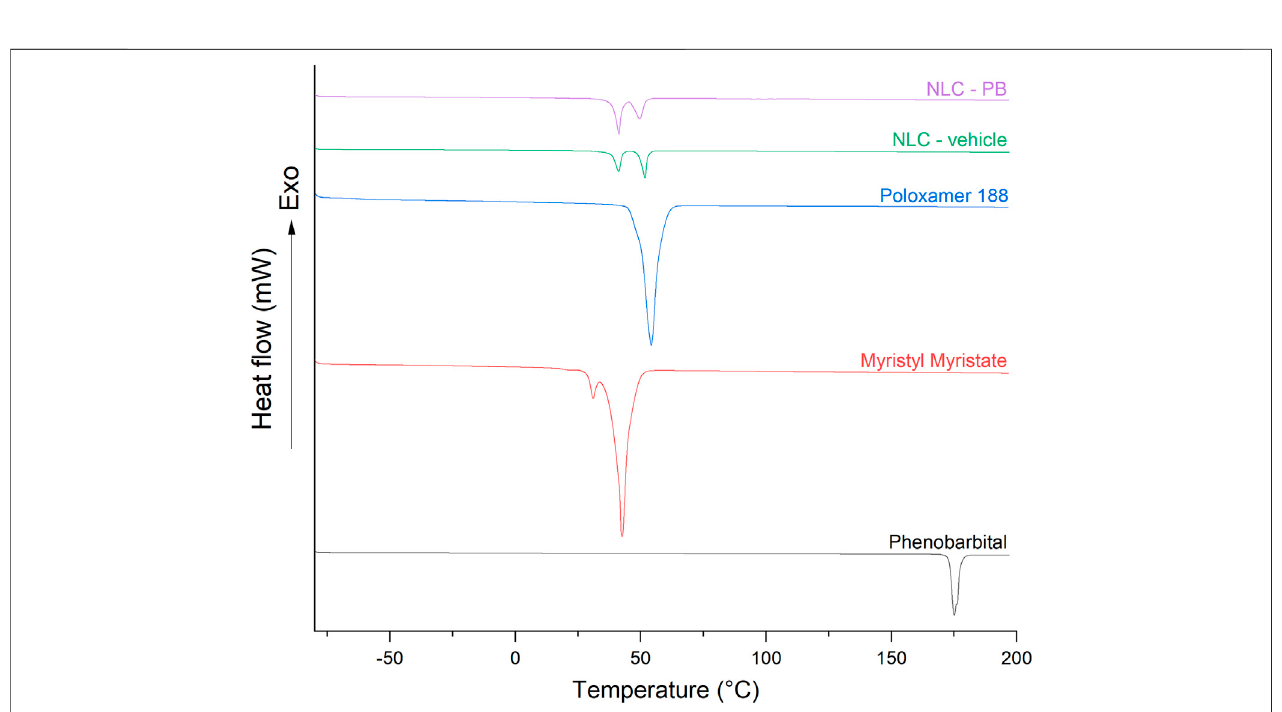
Frontiers in Chemistry |